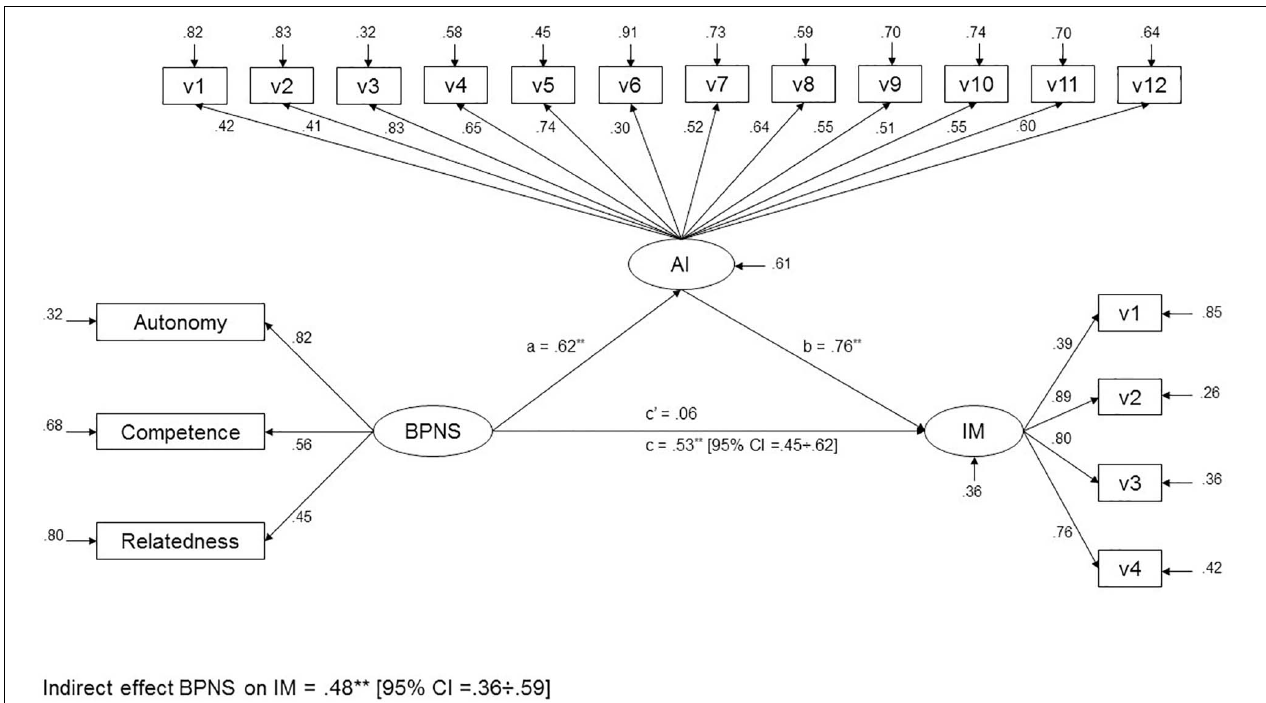
FIGURE 1 | Single mediation model. BPNS, basic psychological needs satisfaction; AI, academic integration; IM, intrinsic motivation; **p < 0.01; standardized